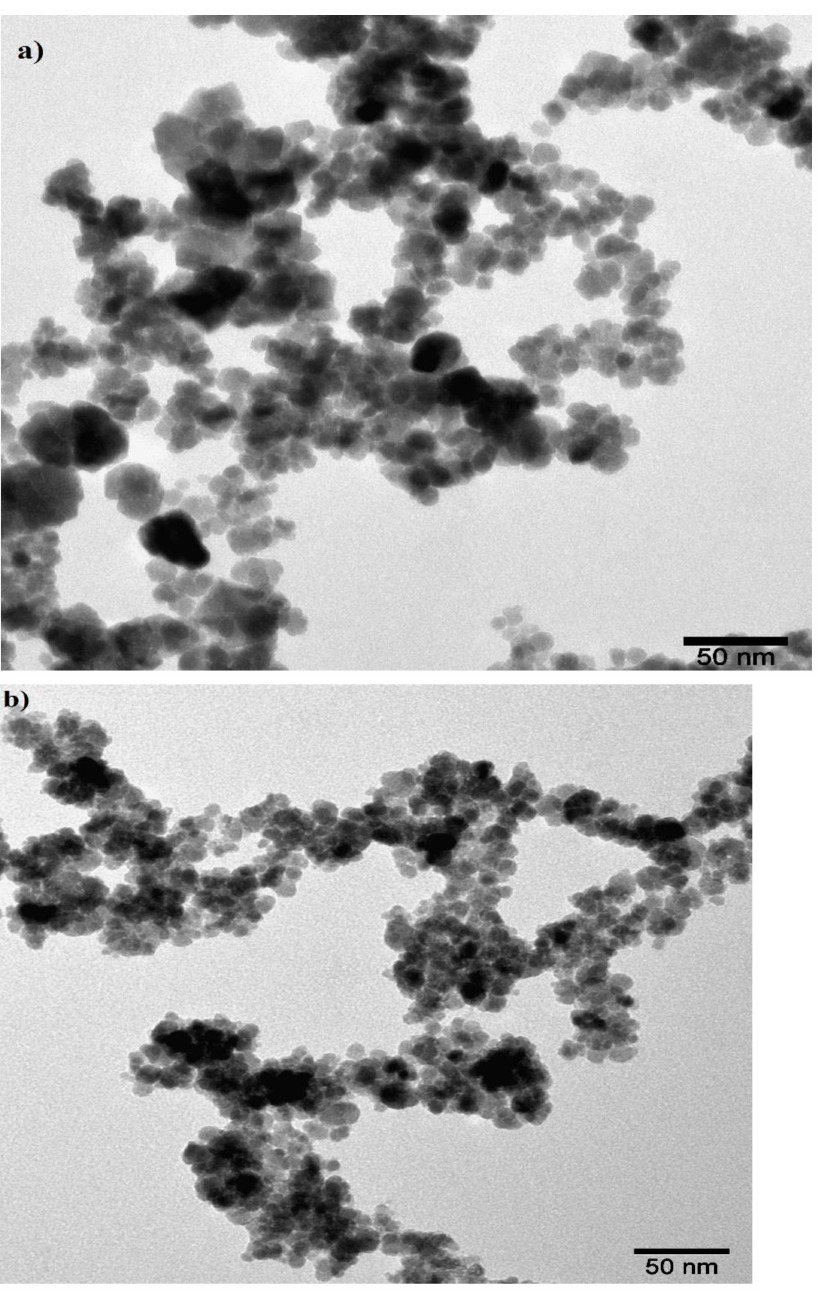
Figure 5. TEM of ( a ) OA-MNPs and ( b )